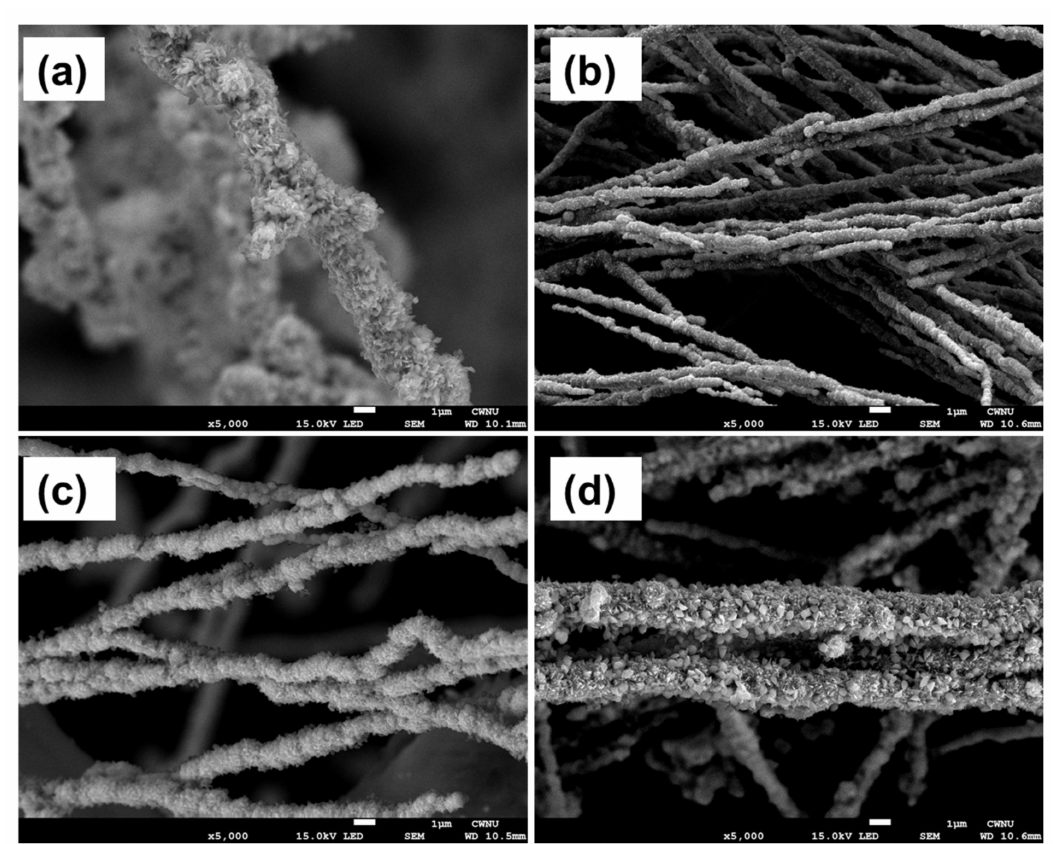
Figure 3. ( a – d ) SEM images ( a ) Ni-Non-Magnetic; ( b ) Ni-Single; ( c ) Ni-Double; ( d ) Ni-Ring at 5 K ×